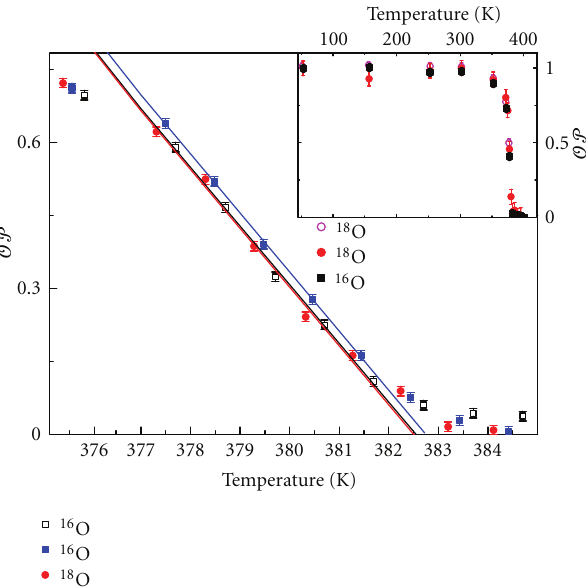
Figure 4: The parameter OP (see (4)) versus temperature near T N for 18 O and 16 O rich samples. The solid lines are fits to the data near the phase transition used to determine T N . The inset shows a second experiment on the entire temperature range. No oxygen isotope e ff ect of T N is observed within experimental